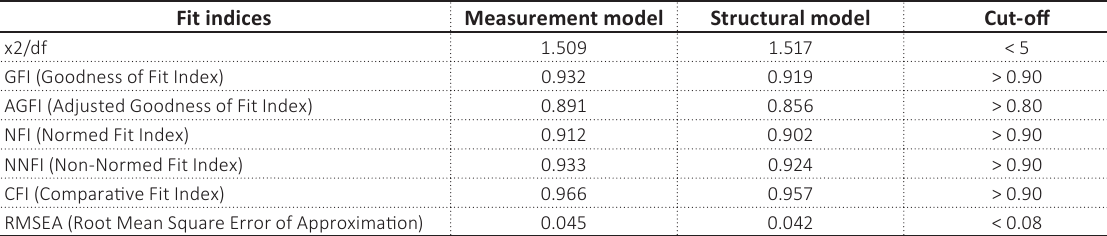
Table 3. Fit indices of the structural model of Islamic mobile banking